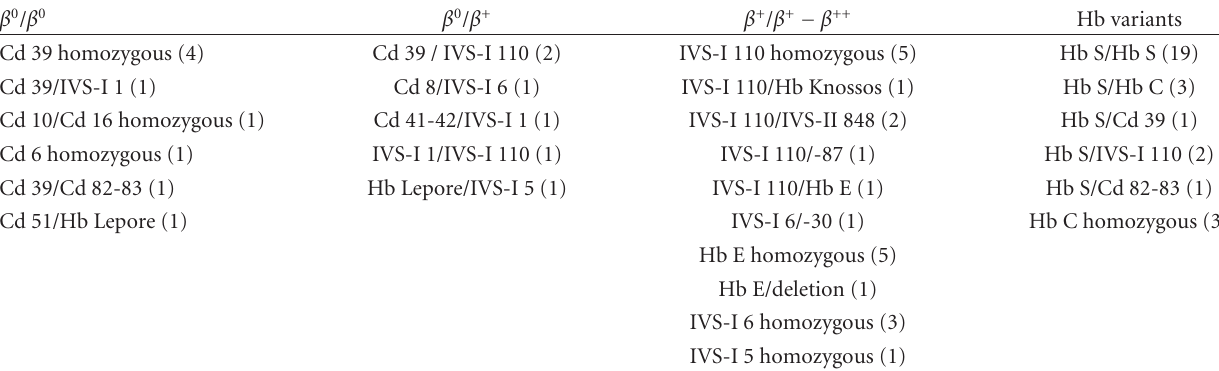
Table 2: Interactions between di ff erent alleles in the β globin genes (65 immigrant patients).